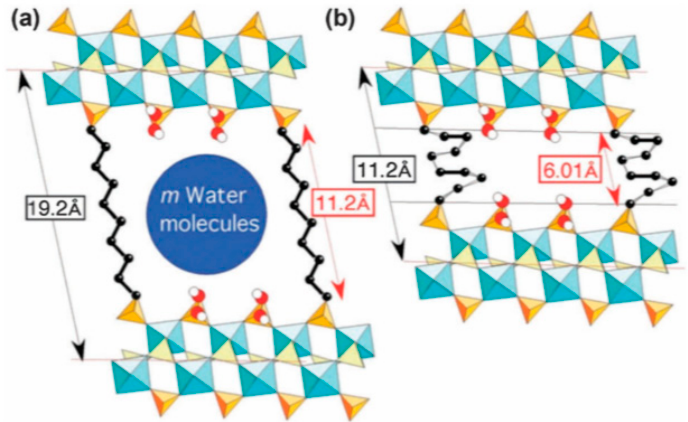
Figure 8. A schematic of the fully hydrated ( a ) and dehydrated ( b ) phosphate/diphosphonate showing the contraction of the carbon chain. Zr octahedra, colored in blue; phosphate tetrahedra,